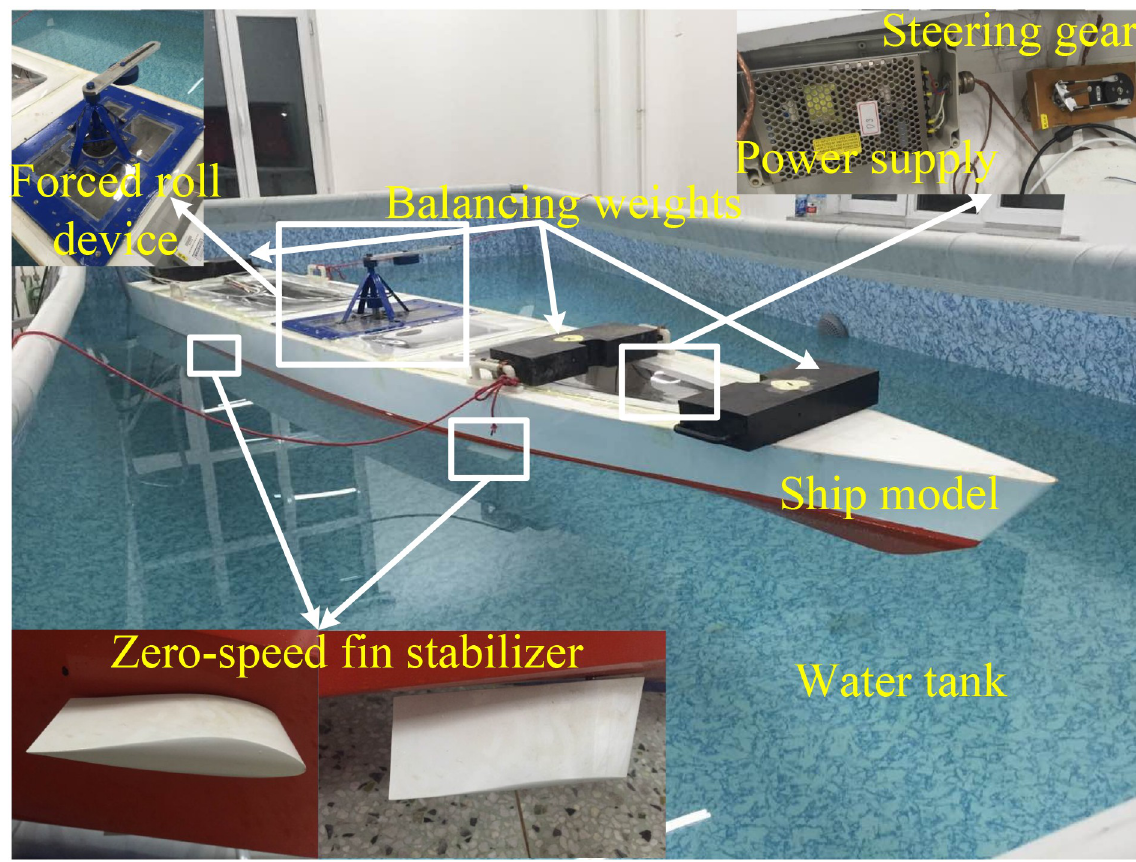
Fig 10. Zero-speed roll reduction